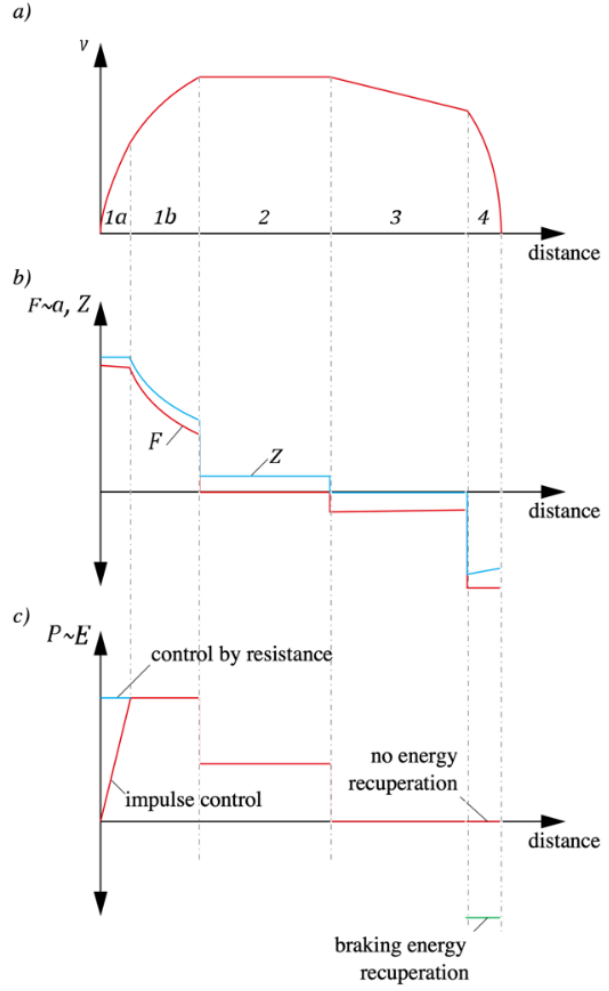
Figure 1. Four train-running modes: 1a—starting (according to the constant acceleration curve), 1b—acceleration (according to the course of the hyperbola of continuous power), 2—running at a constant speed, 3—running from coasting, 4—braking. ( a ) Velocity versus distance graph; ( b ) acceleration and acceleration force (red line) and tractive effort (blue line) versus distance graph; and ( c ) power and energy of running train with impulse (red on first movement phase) and resistance (blue) control or (in phase 4) braking energy with recuperation (green) and without recovery (red). Table 2. List of possible measures within the framework of a reconfiguration of the timetable, taking into account increased energy efficiency of the railways.